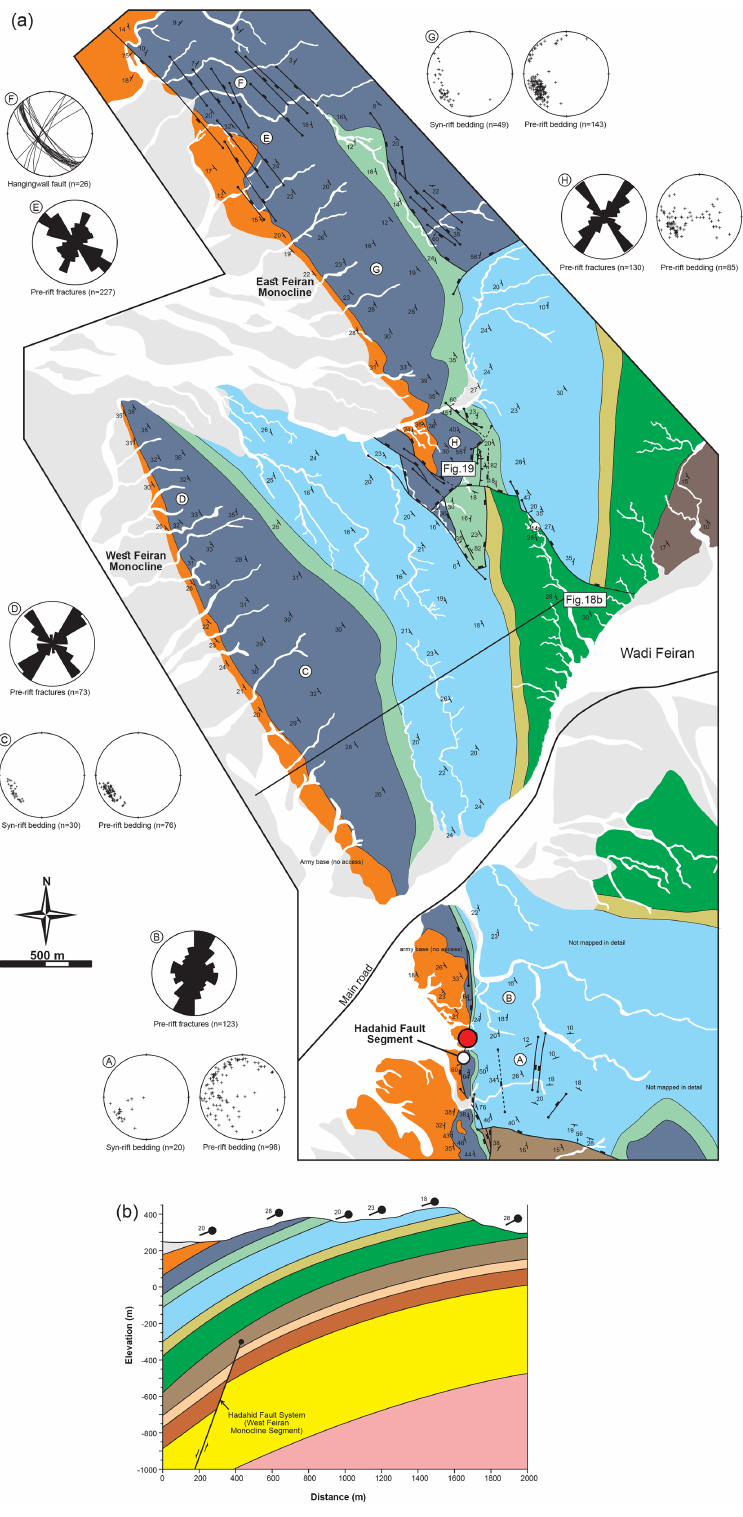
Figure 18. (a) Field map of the Feiran monoclines segment of the Hadahid Fault System. Colour key to stratigraphic units is shown in Fig. 3a. Red dots indicate the approximate boundaries between the identified segments. Lower-hemisphere projection stereonets summarize the dip and dip direction of pre- and syn-rift bedding ( a–g ; location shown on map). Rose diagrams show the trend of fractures in pre-rift strata. The location of the photograph shown in Fig. 19 and the cross sections shown in (b) are indicated. (b) Down-plunge cross section across the West Feiran